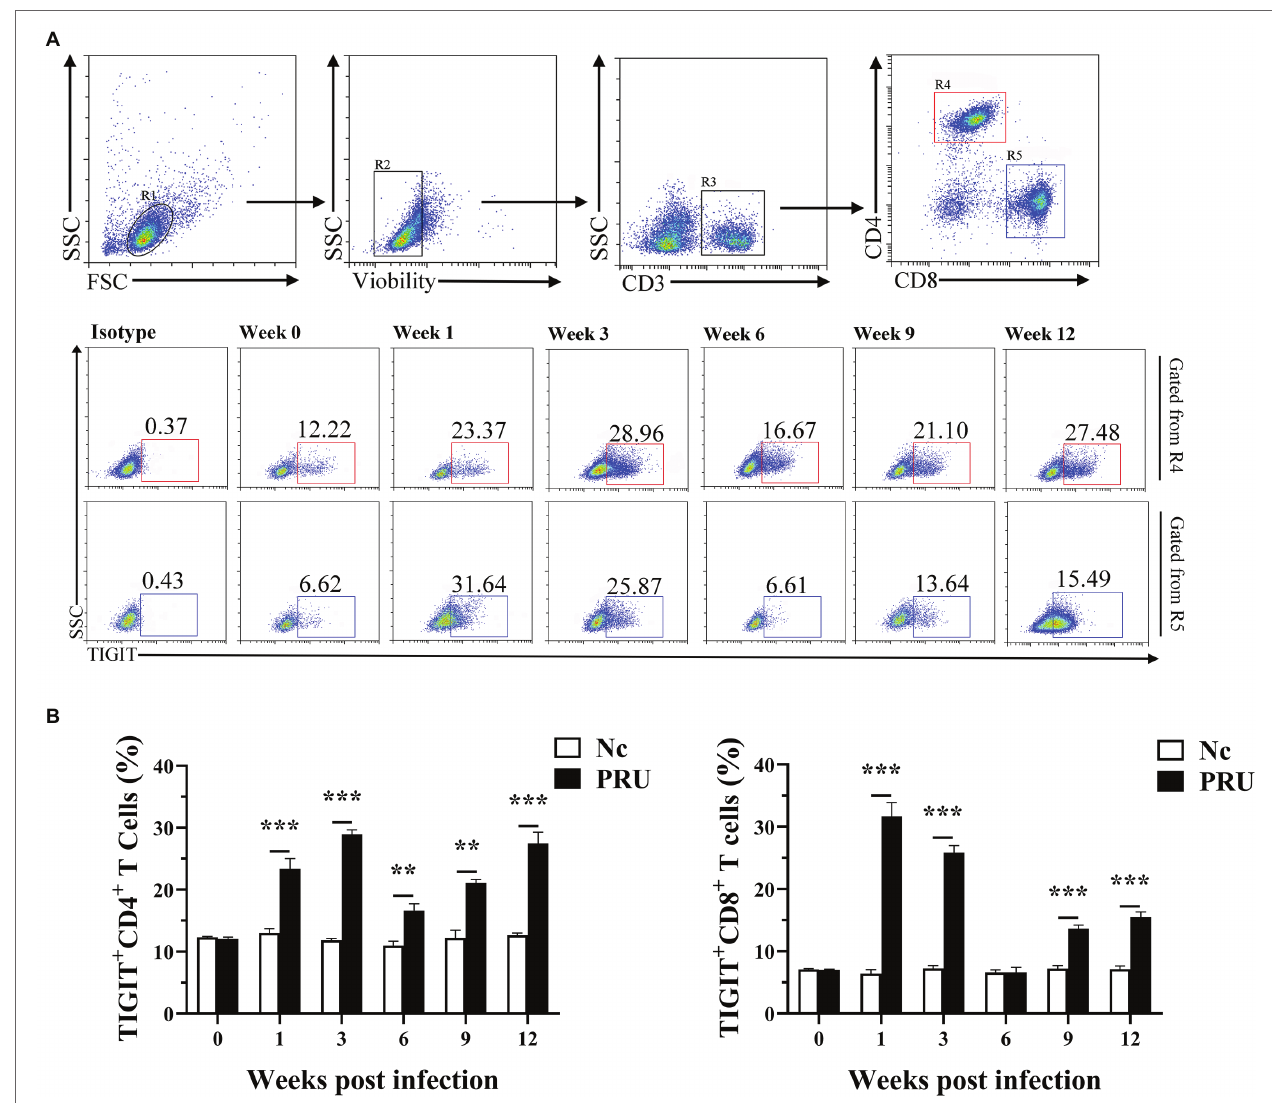
FIGURE 2 | Changes in TIGIT expression on T cells in spleen after T. gondii infection. (A) Proportions of TIGIT + cells among CD4 + and CD8 + T cells in T. gondii - infected (PRU) and normal mice (Nc) after infection. (B) Dynamic changes in the percentages of TIGIT + T cells at different time points. The results are representative of three independent experiments with five mice in each group per experiment, with data denoting means ± SDs. ** p < 0.01 and *** p < 0.001 (compared to the